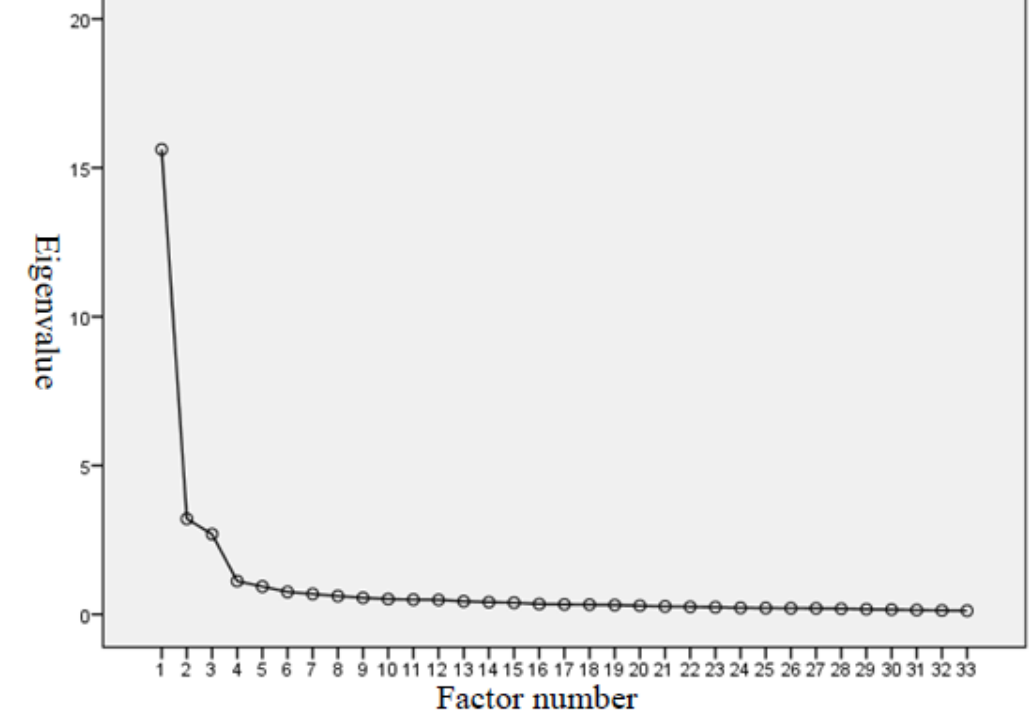
Figure 1. Scree plot for exploratory factor analysis on PIS-HSP.